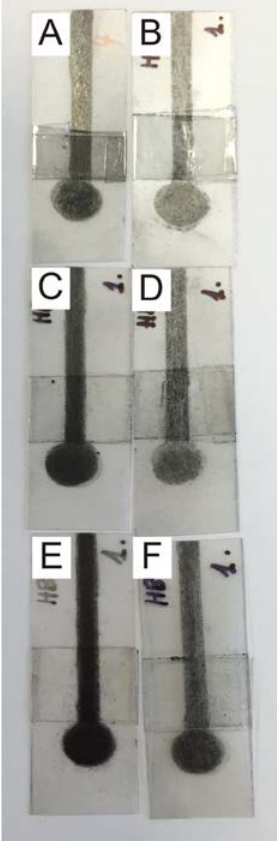
Figure S4. Optical images of PDEs fabricated using different batches of HB pencils, designated as PDE1 ( A ), PDE2 ( B ), PDE3 ( C ), PDE4 ( D ), PDE5 ( E ) and PDE6 ( F ), respectively.